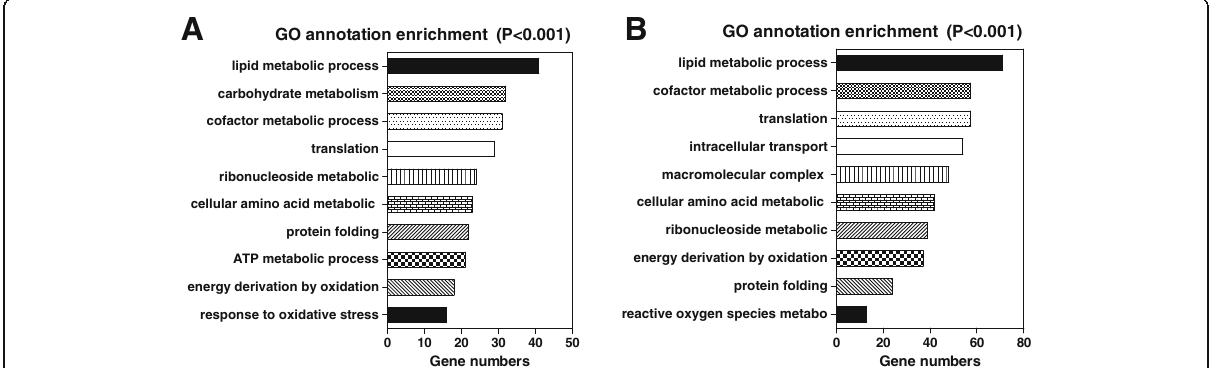
Fig. 3 GO analysis for SS-induced differentiated expressed proteins. GO annotation enriched biological pathways for ( a ) time-toxicity study and b dose-toxicity